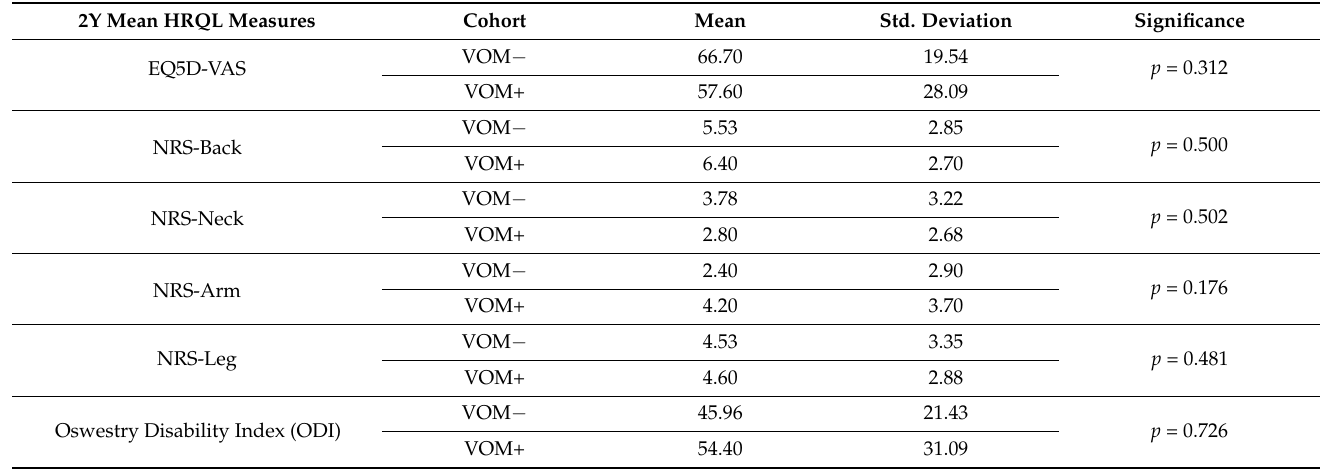
Table 5. Two-year HRQL comparison of VOM+ and VOM −